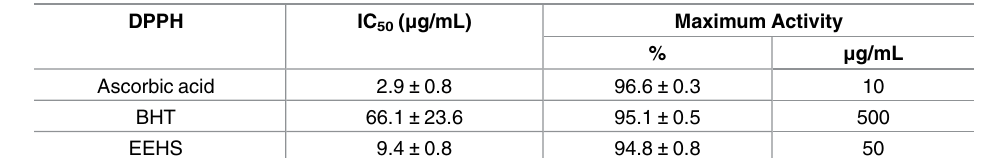
Table 2. IC 50 of the ethanolic extractof Hancornia speciosa Gomes leaves (EEHS) compared with the antioxidant standards ascorbic acid and butylated hydroxytoluene (BHT) along with the percentage of maximum scavenging activity of the free radical 2,2-diphenyl-1-picrylhydrazyl